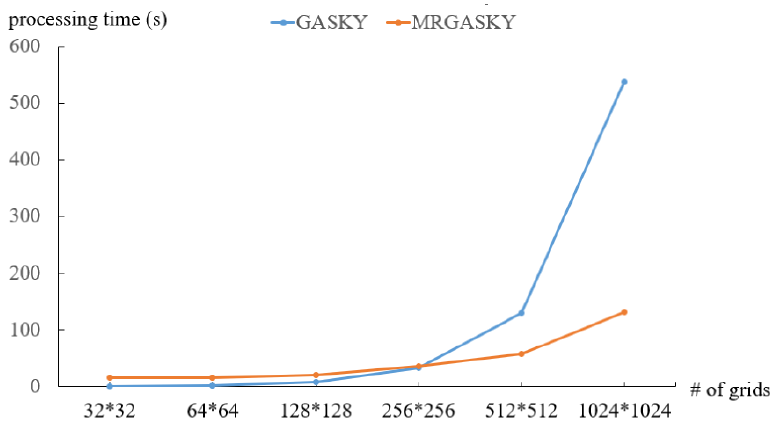
Figure 13. Processing Time of